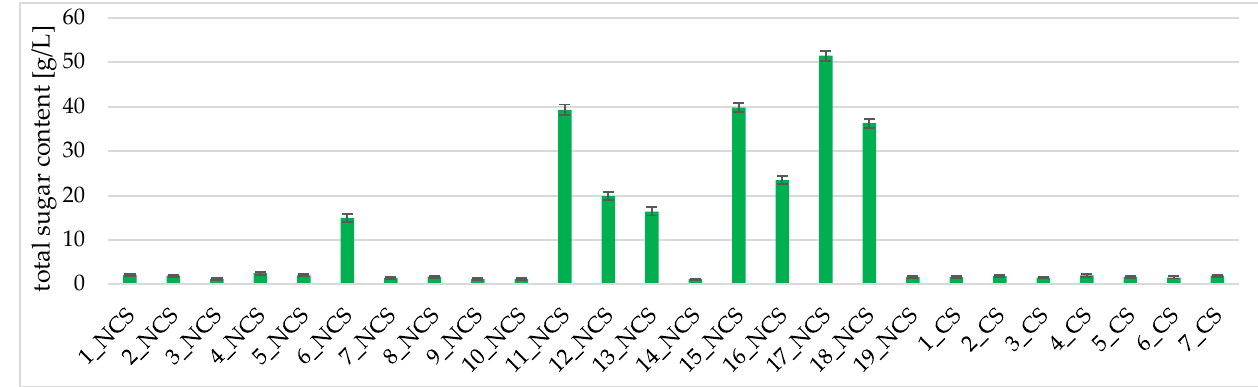
Figure 1. Total sugar content in fermented apple juice with non-commercial (NCS) and commercial (CS) S. cerevisiae or non- Saccharomyces yeast strains.